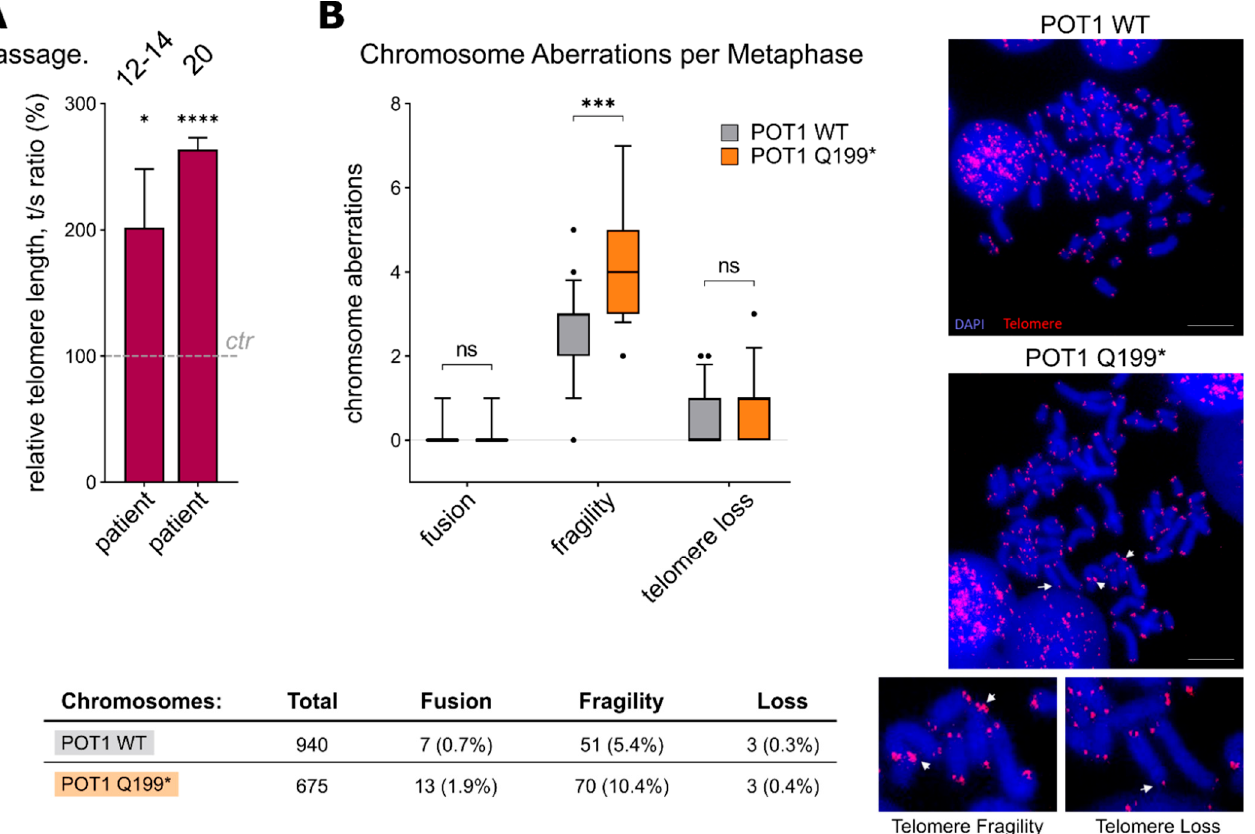
Figure 4. ( A ) Relative telomere length (rTL) analysis by qRT-PCR (comparative ΔΔ Ct method) with DNA isolated from fibroblast samples (the cells were grown for 12–14 passages or 20 passages). Three biological replicates, each with three technical replicates, were performed. The values are expressed as the means ± SEM. ( B ) Left: Telomere fluorescence in situ hybridisation analysis on metaphase chromosomes of the stably transfected WT and p.Q199* POT1 HEK293T cells. Chromosomal aberrations are categorised in telomere fusion, fragility and loss. Right: Representative images of metaphase chromosomes. Red fluorescence shows telomere signals, and chromosomal DNA was stained with DAPI (blue). White arrows mark the respective chromosomal aberration. Scale bar: 10 µm. ns = p > 0.05, * p = ≤ 0.05, *** = p ≤ 0.001, **** = p ≤ 0.0001.